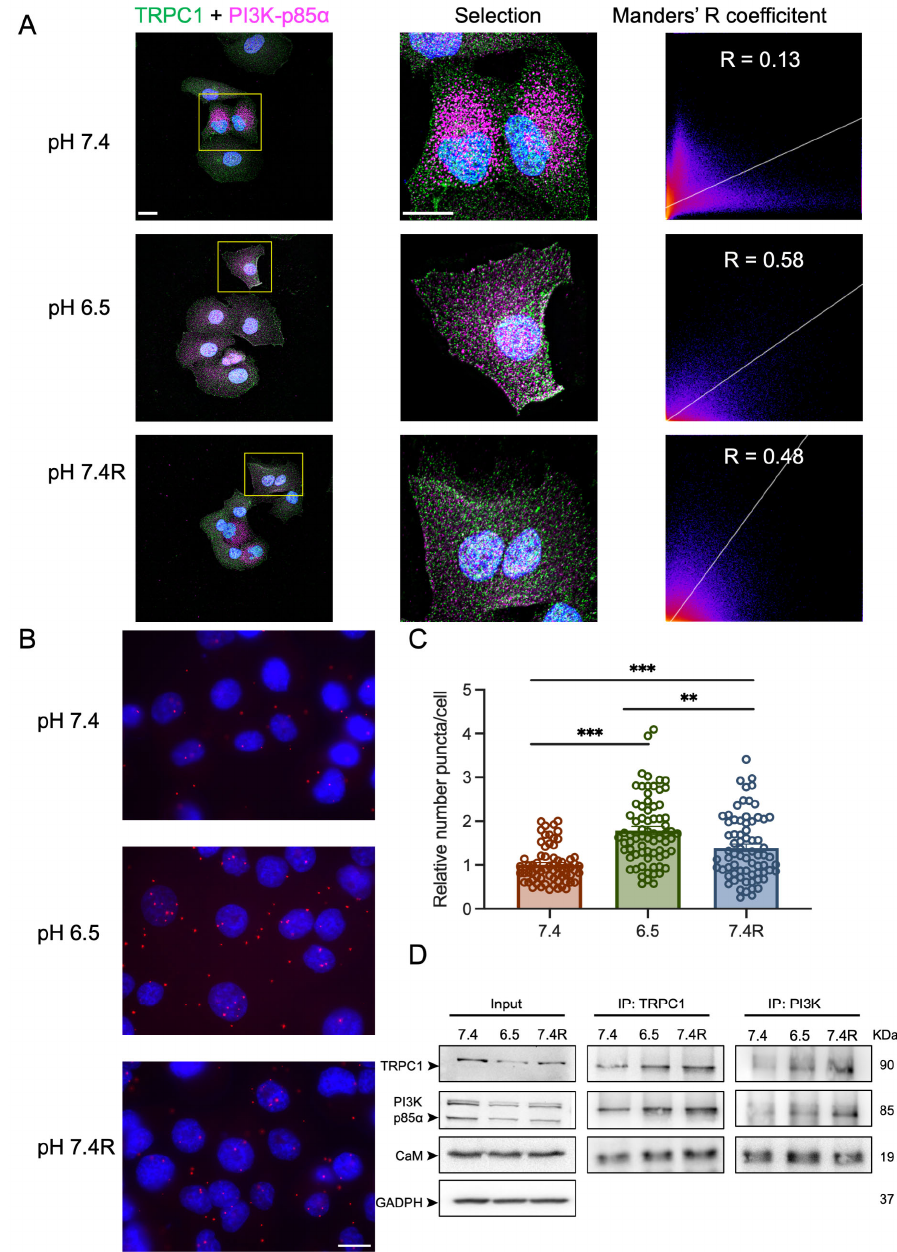
Figure 6. TRPC1 strongly interacts with the PI3K p85 α subunit and CaM in acid adaptation and recovery conditions. ( A ) Representative immunofluorescent analysis of TRPC1 and the PI3K p85 α subunit in PANC-1 cells grown under normal pH (7.4), acid adaptation (6.5) or acid recovery con- ditions (7.4R), scale bars = 20 µ m. Mander’s R coefficient was used to quantify the co-localization between the two fluorophores ( n = 3). ( B ) Representative images of proximity ligation assay (PLA) in PANC-1 cells grown under normal pH (7.4), acid adaptation (6.5), or acid recovery conditions (7.4R), scale bar = 10 µ m. ( C ) Quantification of PLA where conditions are normalized to normal pH conditions (7.4) ( n = 3). Welch’s correction t -test was used to determine the significant difference between different conditions. ** and *** indicate p < 0.01 and 0.001, respectively. ( D ) Representative Western blot analysis of co-immunoprecipitation of TRPC1 and PI3K p85 α subunit with CaM in non-transfected PANC-1 cells grown under normal pH (7.4), acid adaptation (6.5) or acid recov- ery conditions (7.4R), ( n = 3–5). The control pull-down performed with rabbit IgG is presented in Figure S3B. The uncropped blots are shown in File